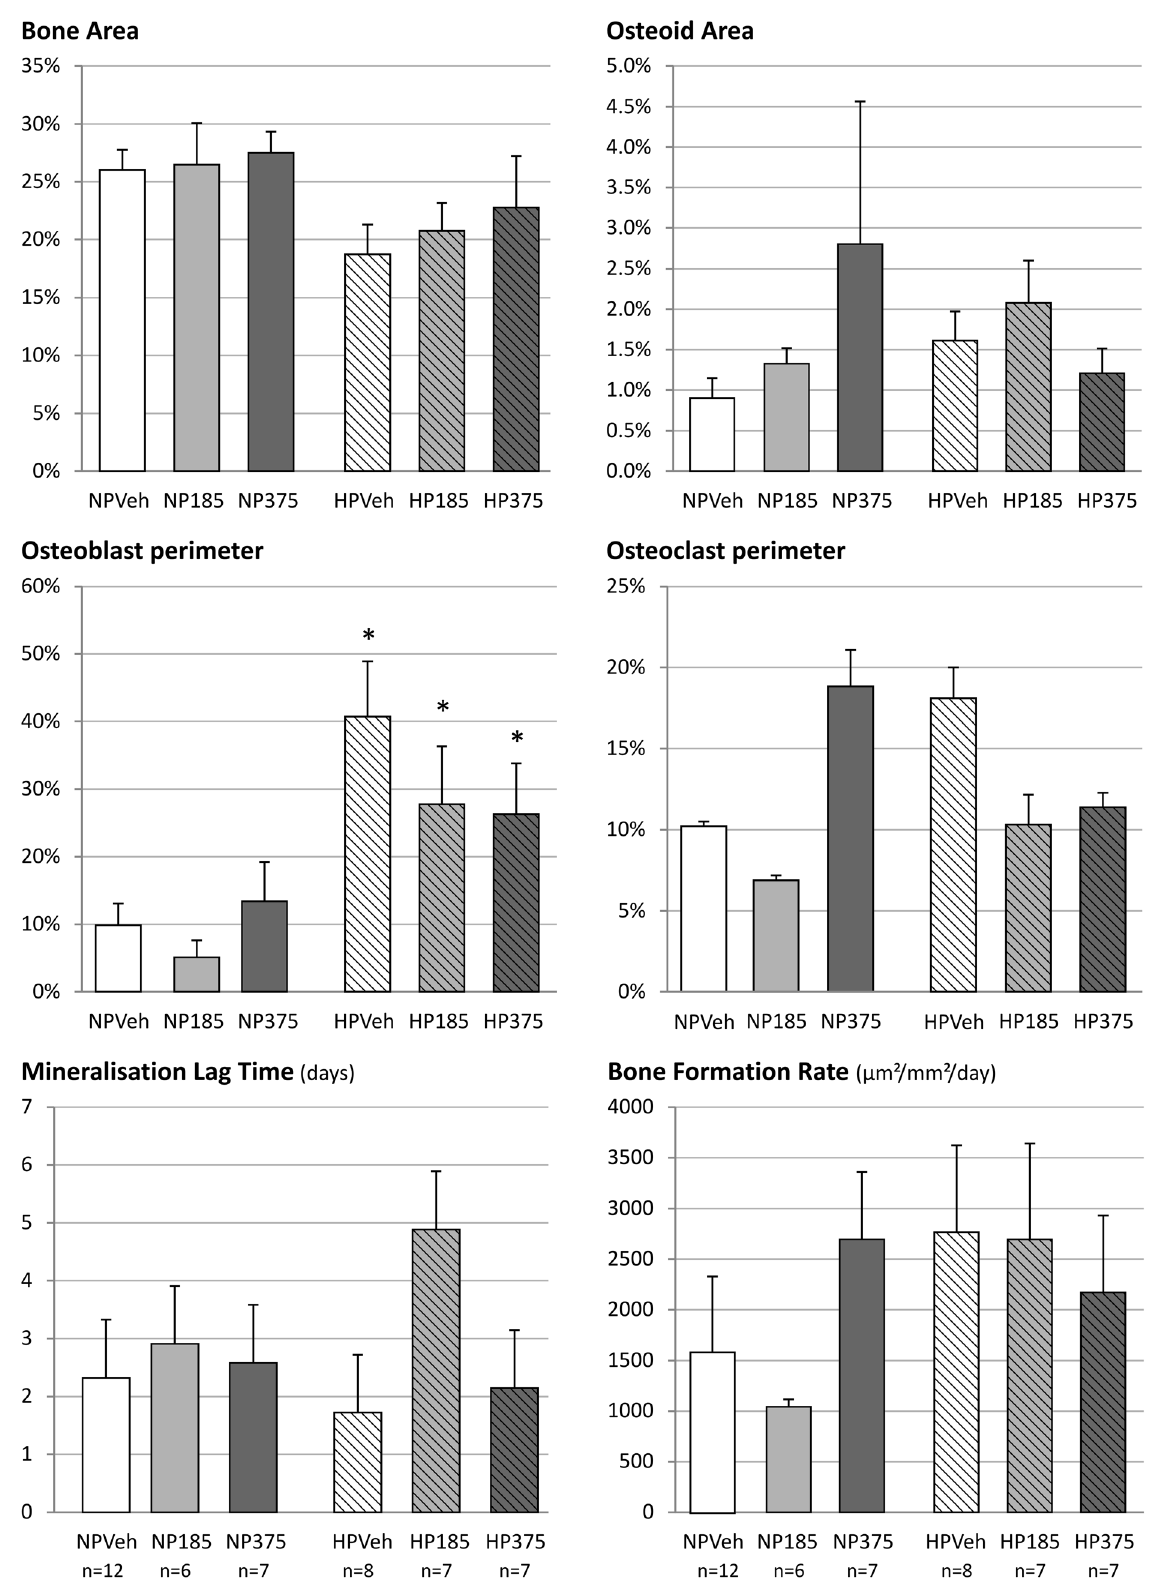
Figure 5. Static and dynamic bone parameters of 5/6 th nephrectomized rats on a normal (NP) or high phosphorus (HP) diet treated with either vehicle (veh), 185 or 375 mg/kg/day CaMg. *: p , 0.05 vs. NP, same dose.